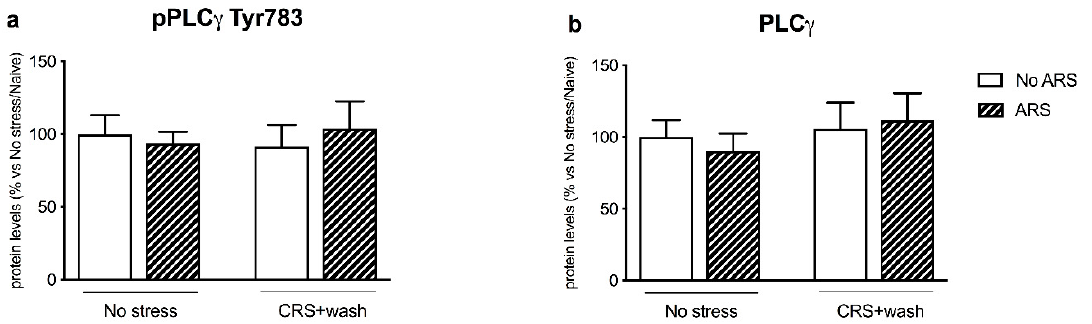
Figure 6. Analysis of PLC γ (phosphorylated and total) (panels a , b ) protein levels in the crude synaptosomal fraction of the prefrontal cortex of chronically stressed rats (CRS) exposed to an acute stress challenge (ARS) after 3 weeks of washout (wash). The data, expressed as a percent change of No stress/No ARS animals, are the mean ± SEM.